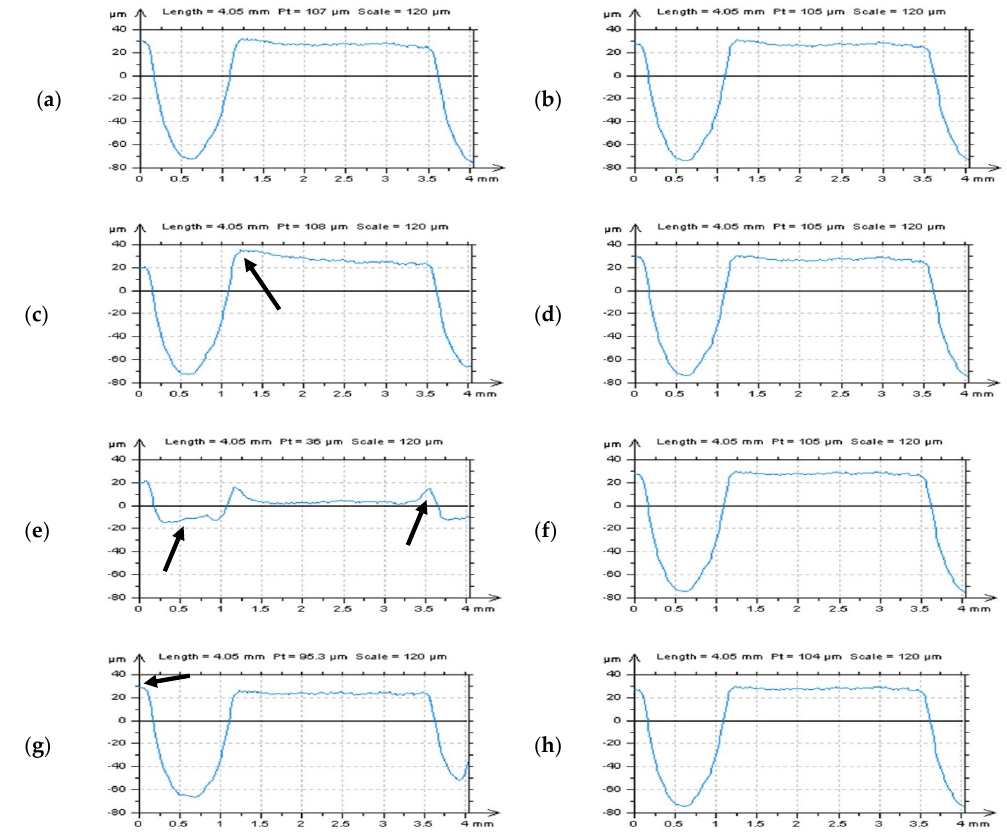
Figure 6. Profiles extracted from the turned cylindrical surface containing deep and wide dimples after an areal form removal by the polynomial of 2nd ( a , b ) or 4th ( c , d ) degree, application of the commonly used regression ( e , f ), or robust ( g , h ) Gaussian filter, cut-off = 0.8 mm, regular algorithms (left column) and modified procedures with a thresholding method (right